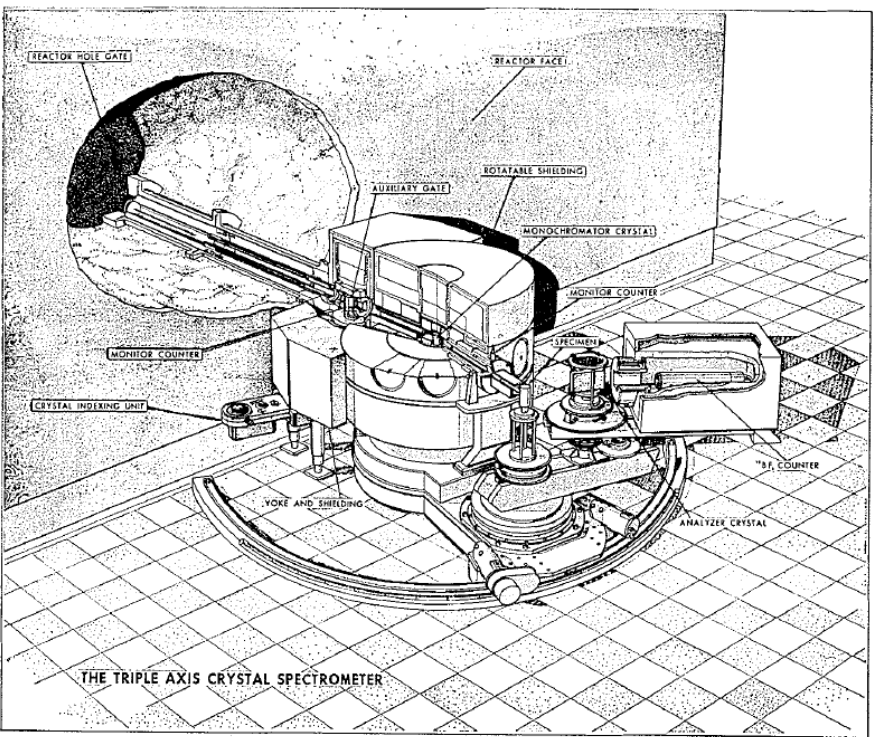
Figure 18. Cutaway drawing of the C5 triple-axis crystal spectrometer at the C-face of the National Research Universal (NRU) reactor. This figure is taken from Figure 2a of ref. [58] courtesy of Canadian Science Publishing and its licensors (DOI 10.1139/p65-135).